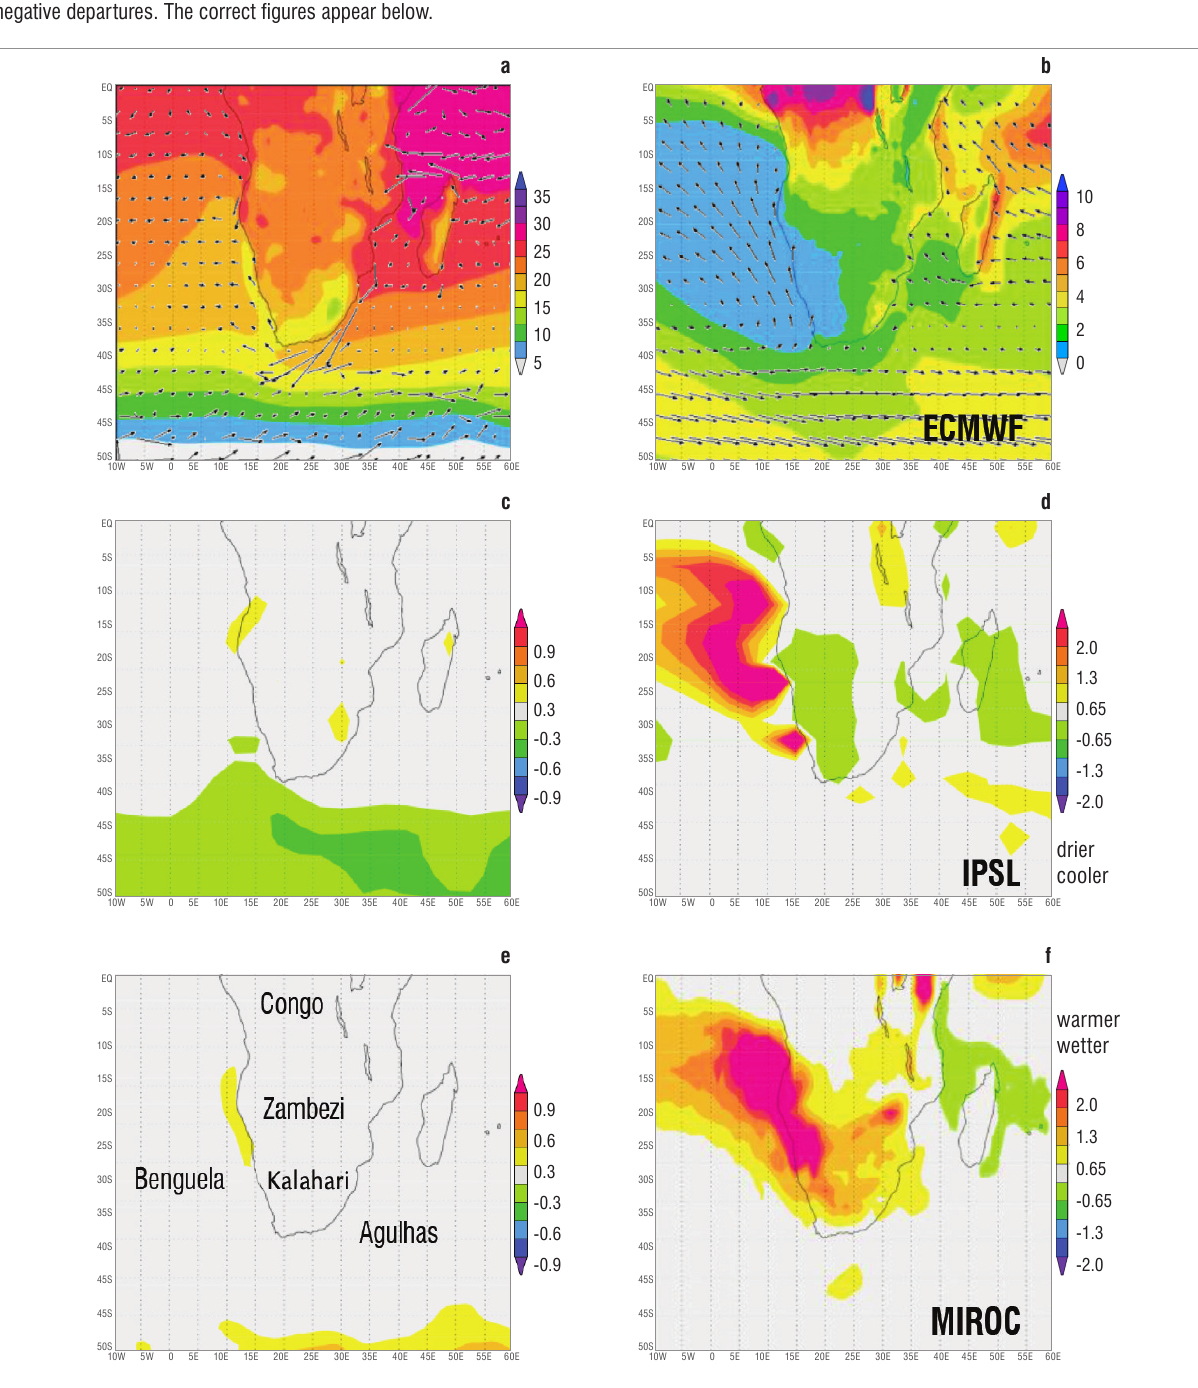
Figure 1: ECMWF climatology for (a) temperature (°C) and (b) rainfall (mm/day) and difference in IPSL temperature (c) and (d) and MIROC A1B (e) temperature and (f) rainfall simulations for 1980–2010. Vectors for SODA surface currents are included in (a) and ECMWF wind stress in (b). (e) Key places mentioned in the